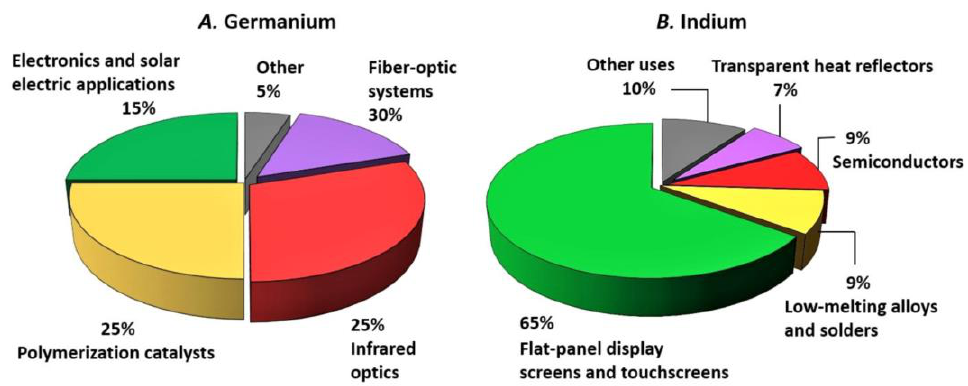
Figure 5. Pie charts showing major end uses of ( A ) germanium and ( B ) indium as a percentage of global consumption in 2012. Data from [67].